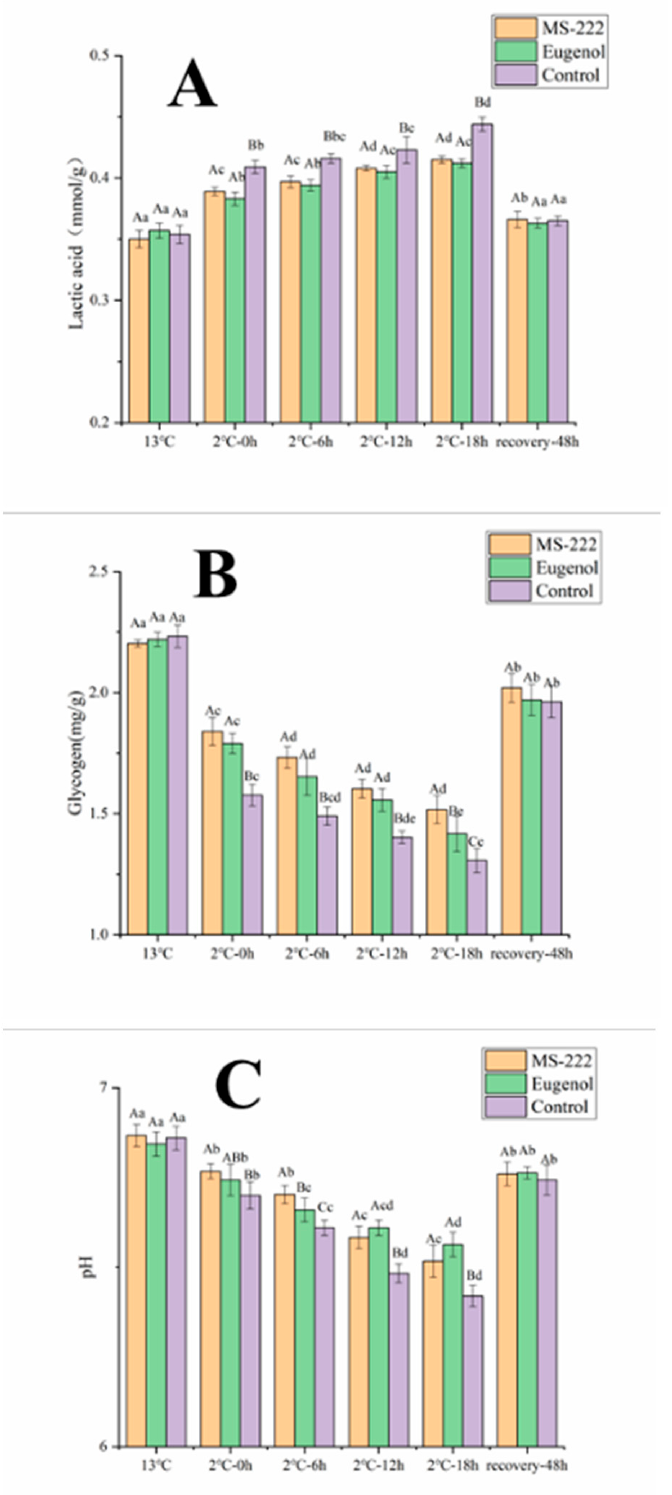
Figure 1. Flesh glycogen ( A ), lactic acid ( B ) and pH ( C ) changes of turbot affected by low temperature transport stress. Different capital letters indicate significant differences in means between different treatment groups. Different lowercase letters indicate significant differences in means between the same treatment groups ( p < 0.05).